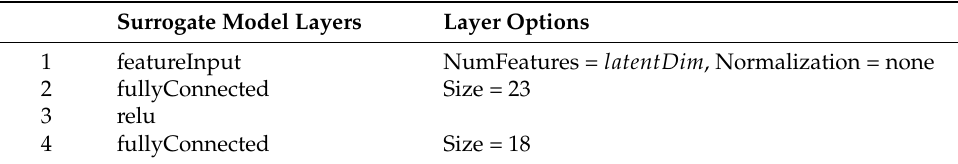
Table 4. Surrogate model